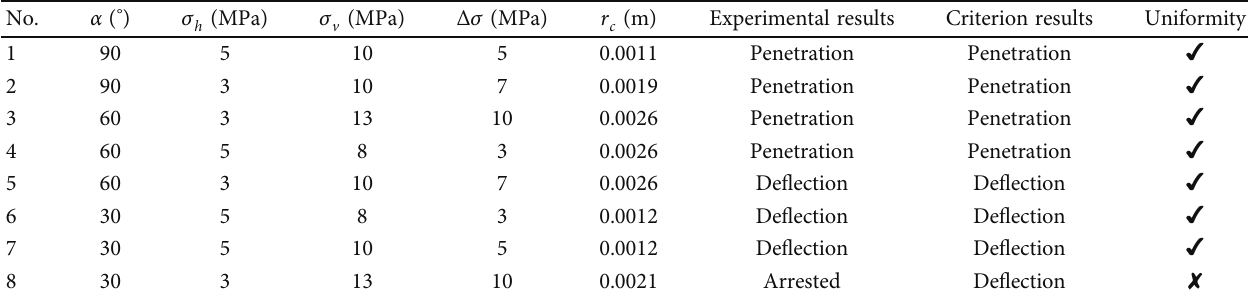
Table 2: Comparison of Zhou et al. ’ s experimental results and the results of the proposed criterion.